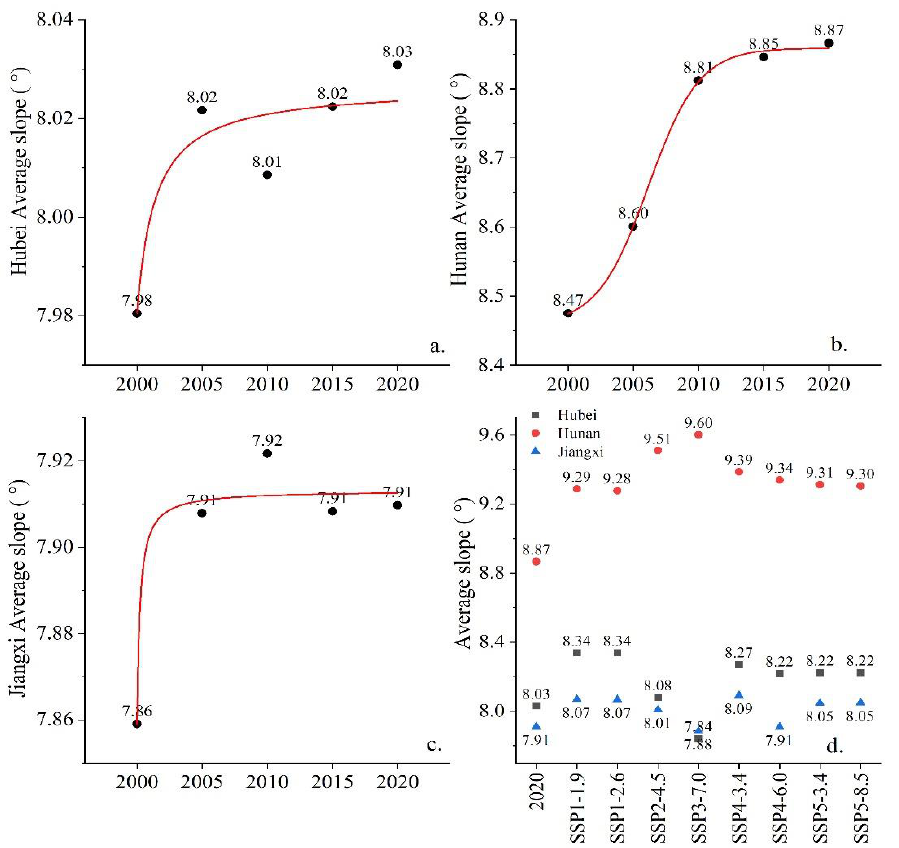
Figure 9. Changes of average slopes in the three provinces in 2000–2020 and predictions in 2035 under different scenarios. ( a ) Average slope in Hubei Province in 2000–2020. ( b ) Average slope in Hunan Province in 2000–2020. ( c ) Average slope in Jiangxi Province in 2000–2020. ( d ) Average slope in the three provinces in 2035 under different scenarios.